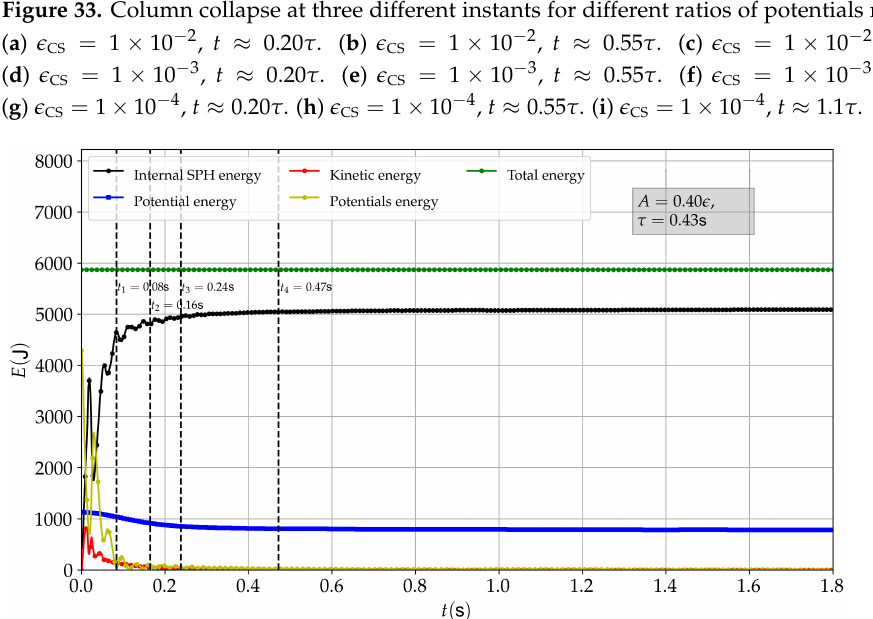
Figure 33. Column collapse at three different instants for different ratios of potentials magnitude.